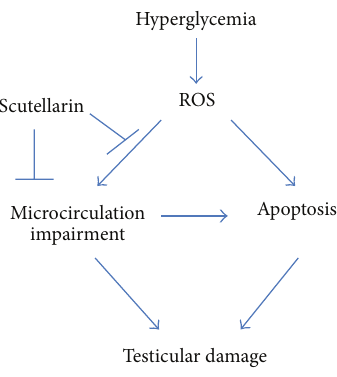
Figure 6: Schematic diagram for the mechanism by which SCU protects testicular damage in diabetic